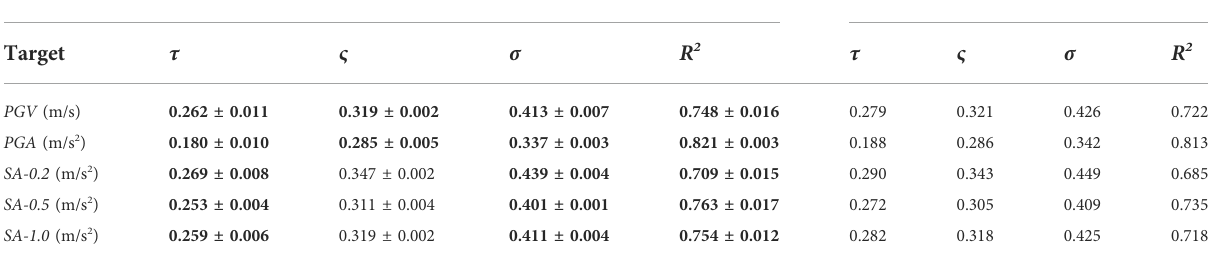
TABLE3Performanceresultswiththeproposedapproach,comparedwithMOD3of(Sharmaetal.,2013)inthetestdata,reportedintermsofmean± standard deviation for the ANN model. The best results are reported in bold. ANN